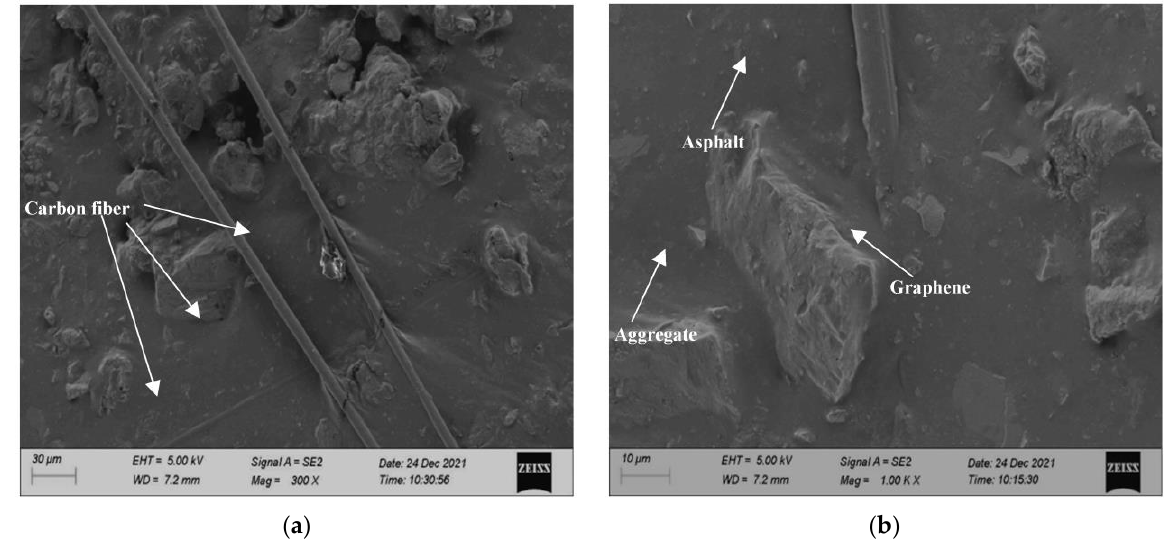
Figure 18. Microstructure of CGA-10. ( a ) 300 times, ( b ) 1000 times.